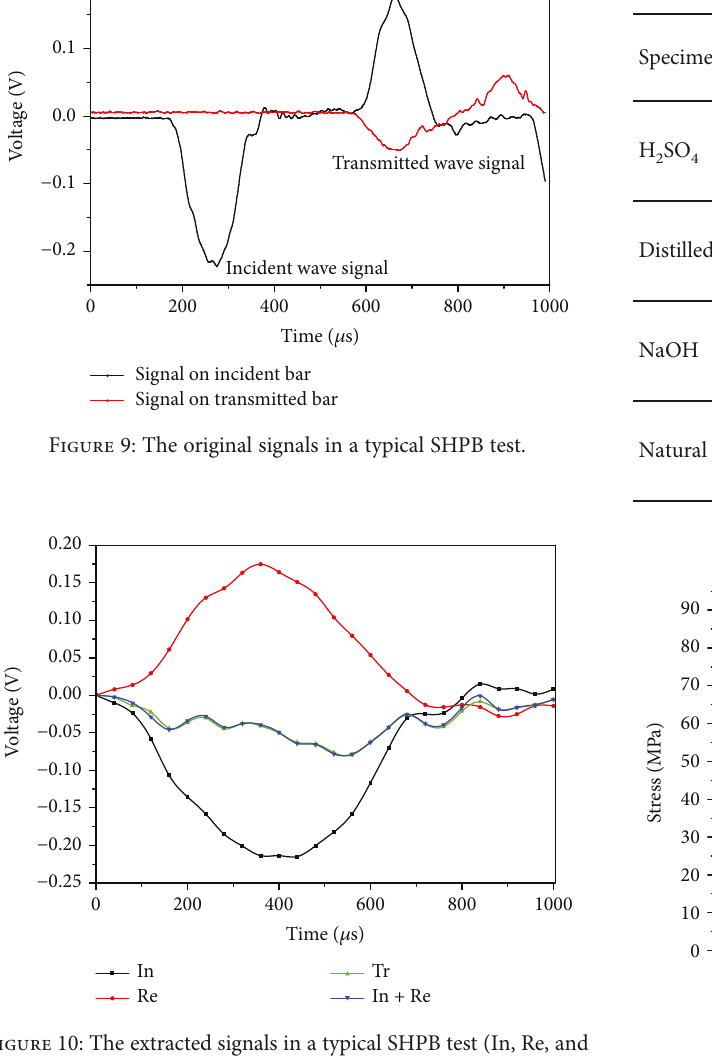
Table 4: Dynamic compression test results for specimens with di ff erent chemical solutions.